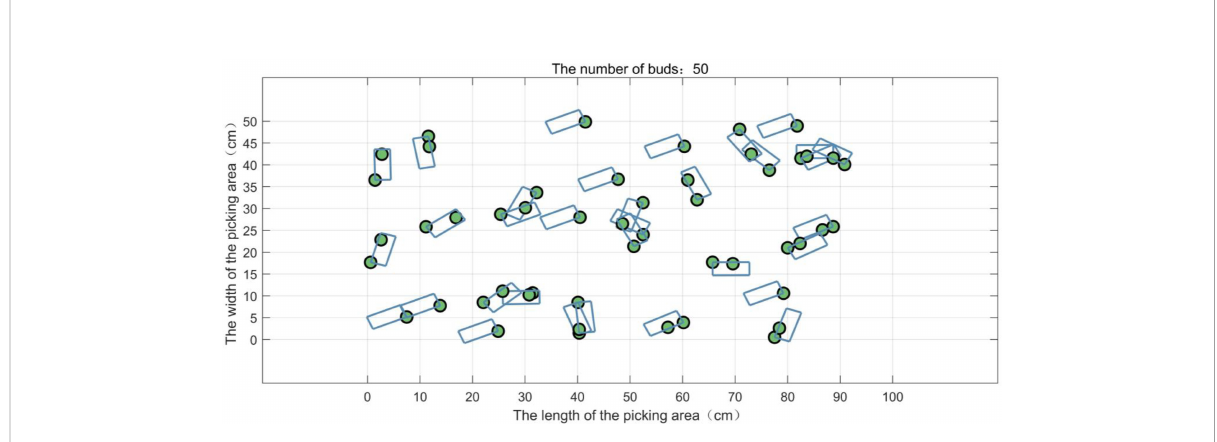
FIGURE 9 The picking boxes in BOX BEST (before fi